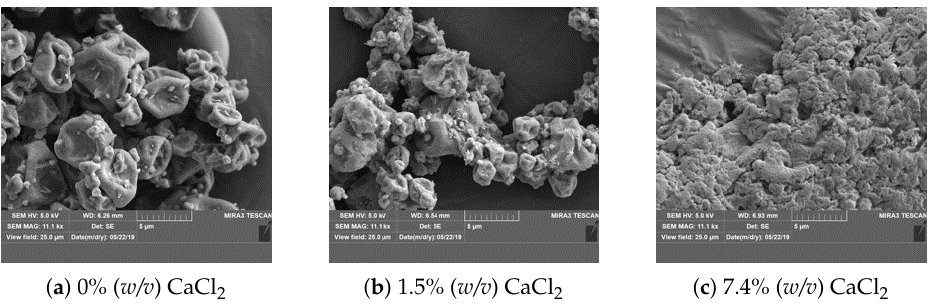
Figure A5. Effect of CaCl 2 concentration on particle morphology. All formulations were spray dried from buffer at pH 5.5 containing medium-sized silica NP functionalised with aminopropyl moieties.